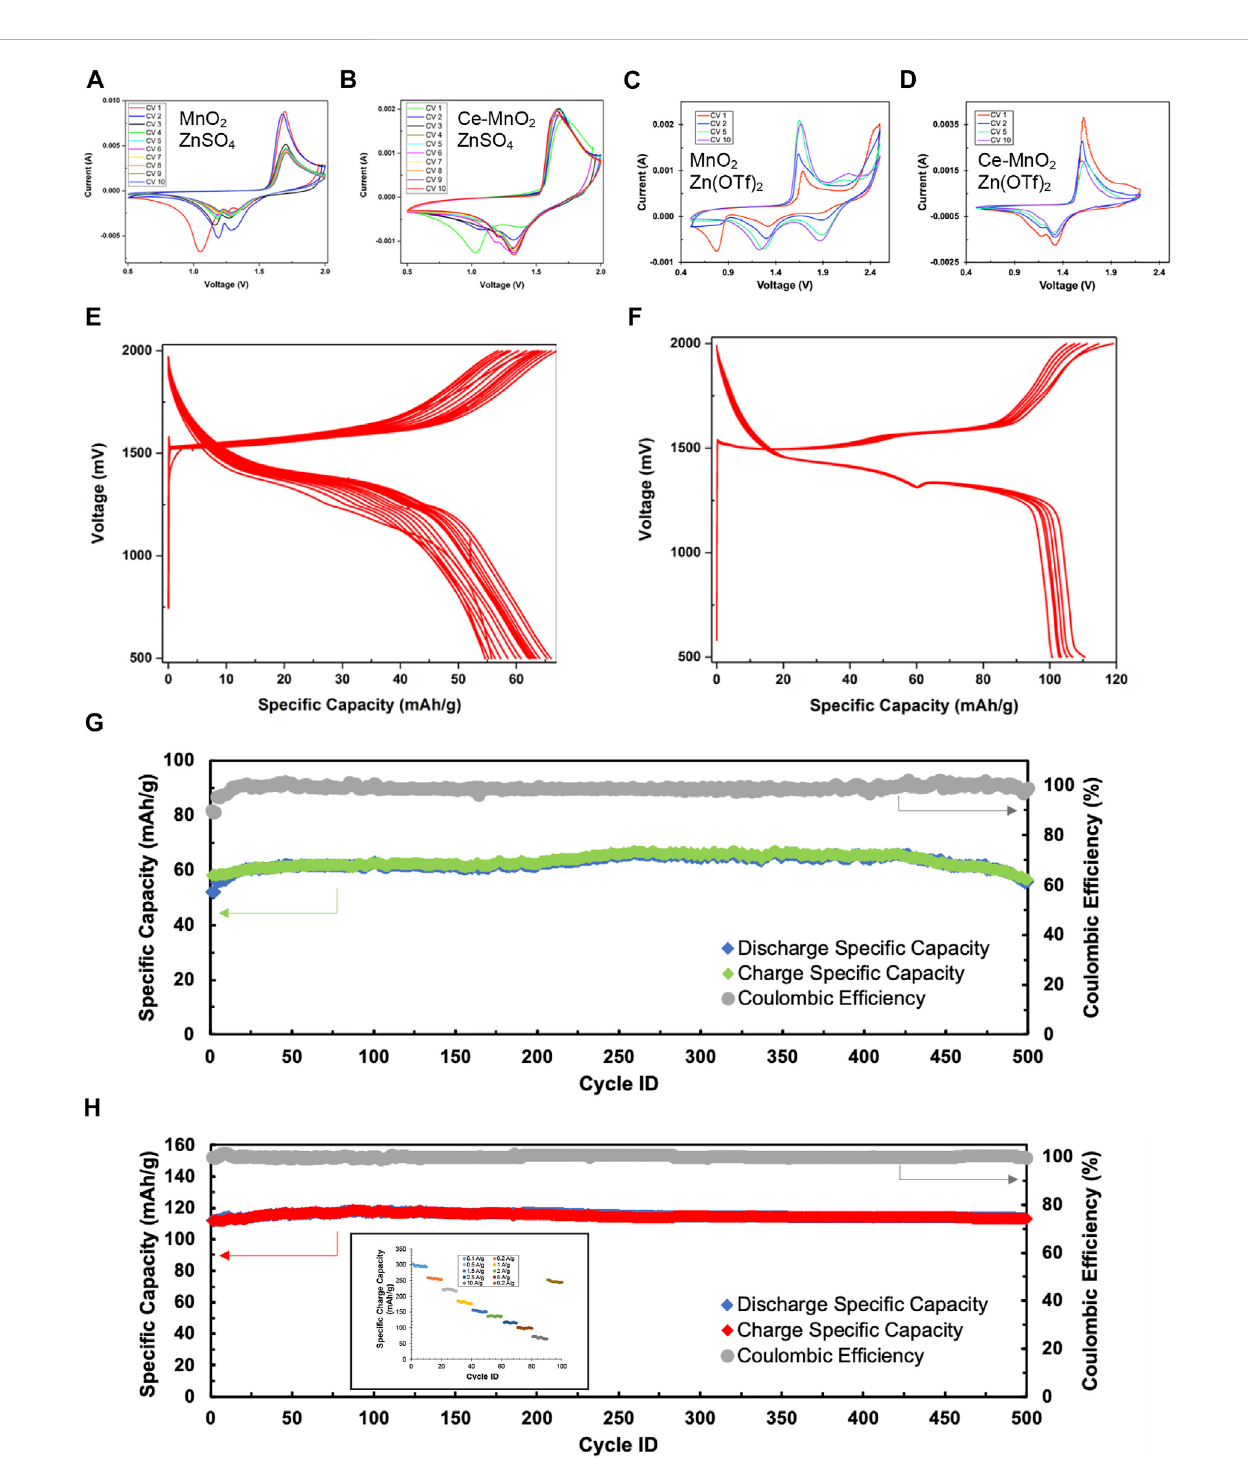
FIGURE 3 Cyclicvoltammogramsof (A) MnO 2 and (B) Ce-MnO 2 cathodematerialswith3 MZnSO 4 ,and (C) MnO 2 and (D) Ce-MnO 2 with3 MZn(CF 3 SO 3 ) 2 testedin half-cell ARZIBs using Zn metal as reference and counter electrode at a scan rate of 1 mV/s. Voltage pro fi les during galvanostatic charge/discharge (GCD) at current density of 2500 mA/g with 3 M ZnSO 4 of (E) MnO 2 and (F) Ce-MnO 2 . Cycling stability measurements during GCD cycling of (G) MnO 2 and (H) Ce- MnO 2 cathode in 500 cycles (inset: rate